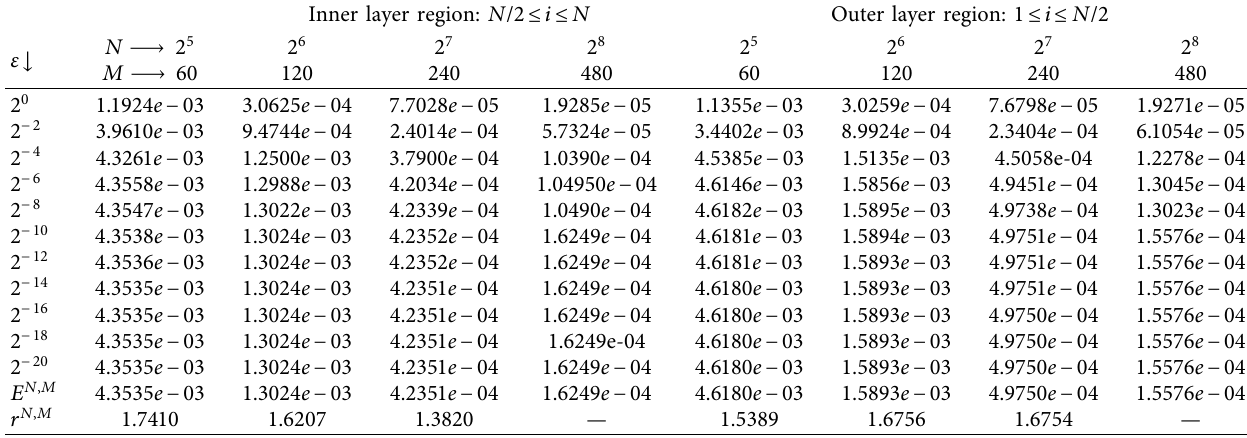
Table 2: Maximum absolute error of Example 2 using the proposed scheme at δ � 0 . 3 ε .